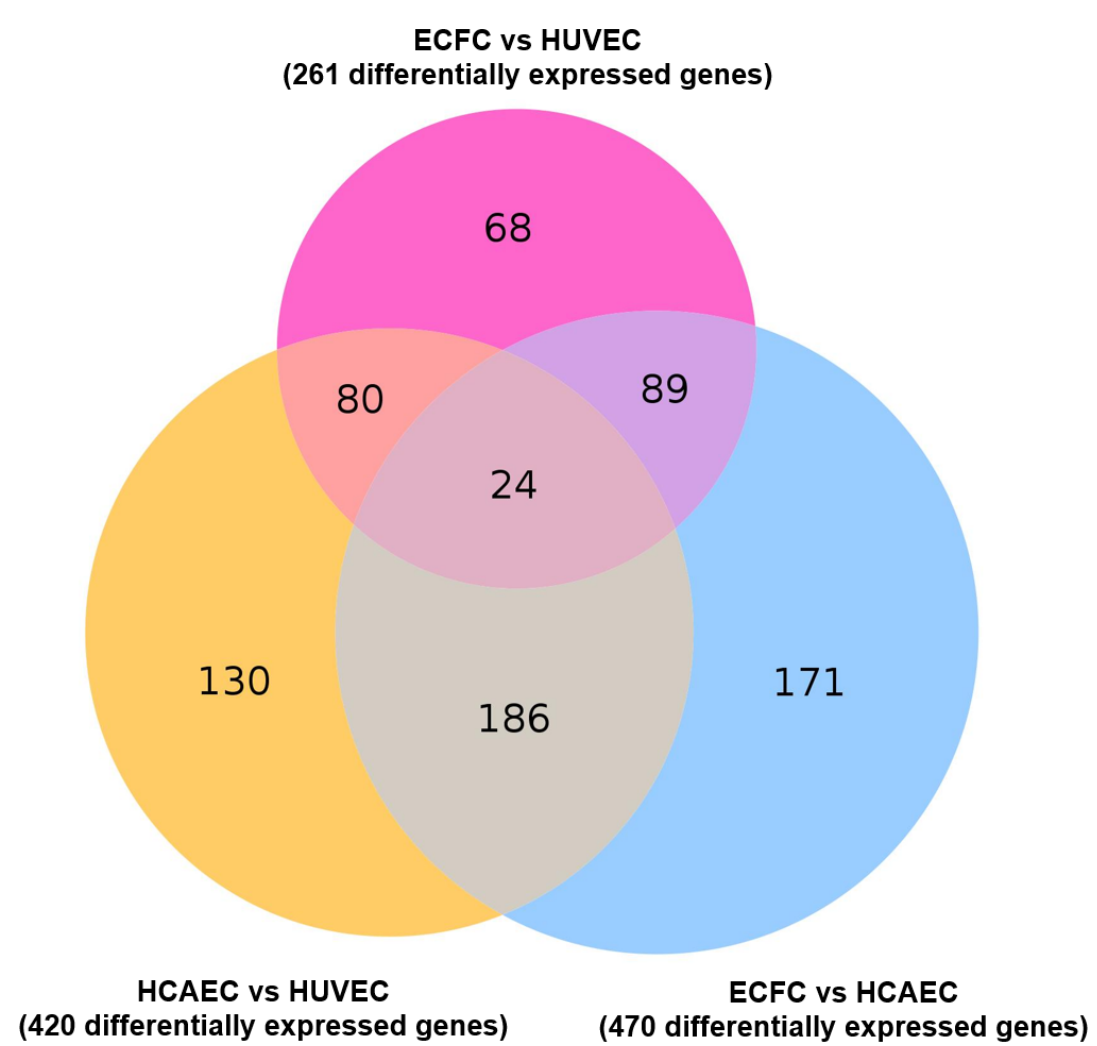
Figure 6. Venn diagram for the genes di ff erentially expressed in ECFC, HUVEC and HCAEC.